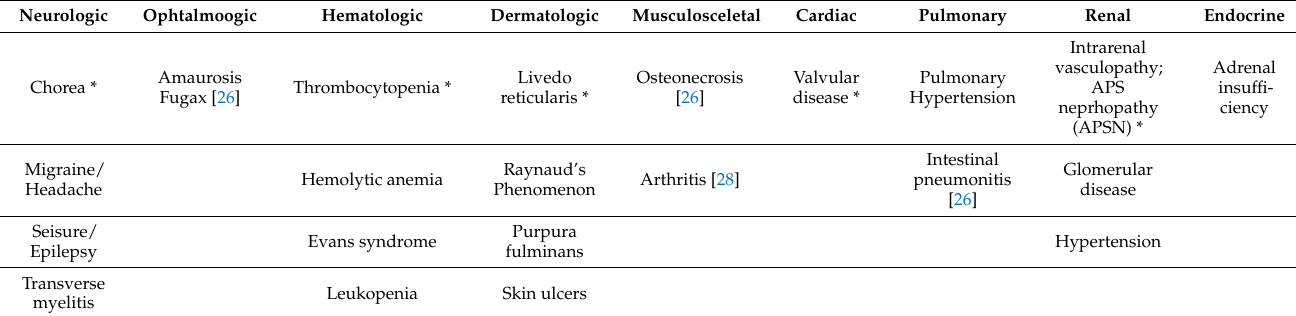
Table 1. Main non-criteria manifestations of antiphospholipid syndrome reported in children manifestations described in this